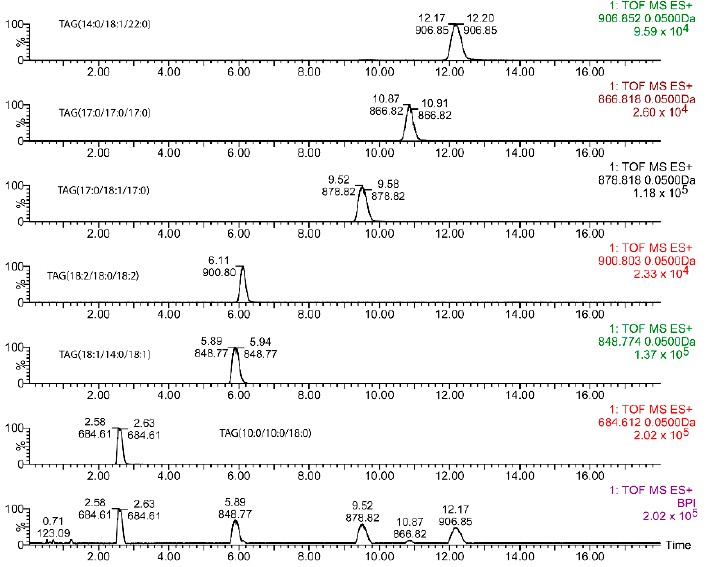
Figure 1. Typical base peak chromatogram (lower panel) and extracted ion chromatograms for the diverse triacylglycerols (TAGs) used in this study. TAG concentration was 10 μ g/mL (see Section 4 for mM concentration equivalence).